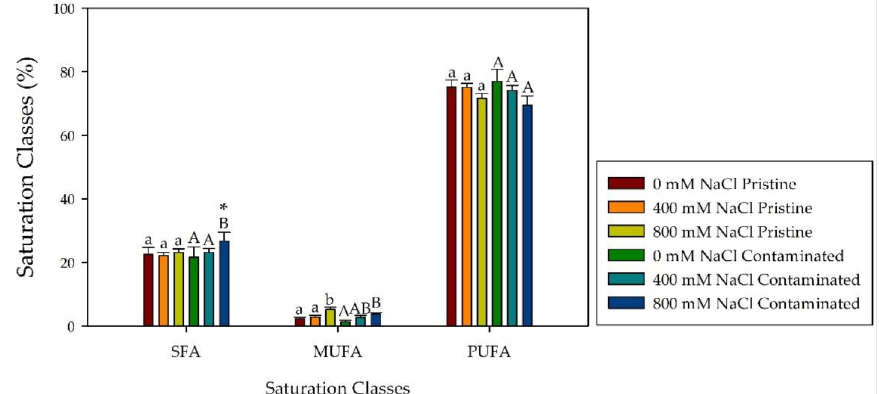
Figure 7. Saturated fatty acid (SFA), monounsaturated fatty acid (MUFA) and polyunsaturated fatty acid (PUFA) relative concentration (%, average ± standard error, N = 5) in S. patens leaves from pristine and heavy metal contaminated sites, along with the tested NaCl concentrations. Letters indicate significant differences between treatments at p < 0.05; asterisks mark significant differences between populations at p < 0.05.